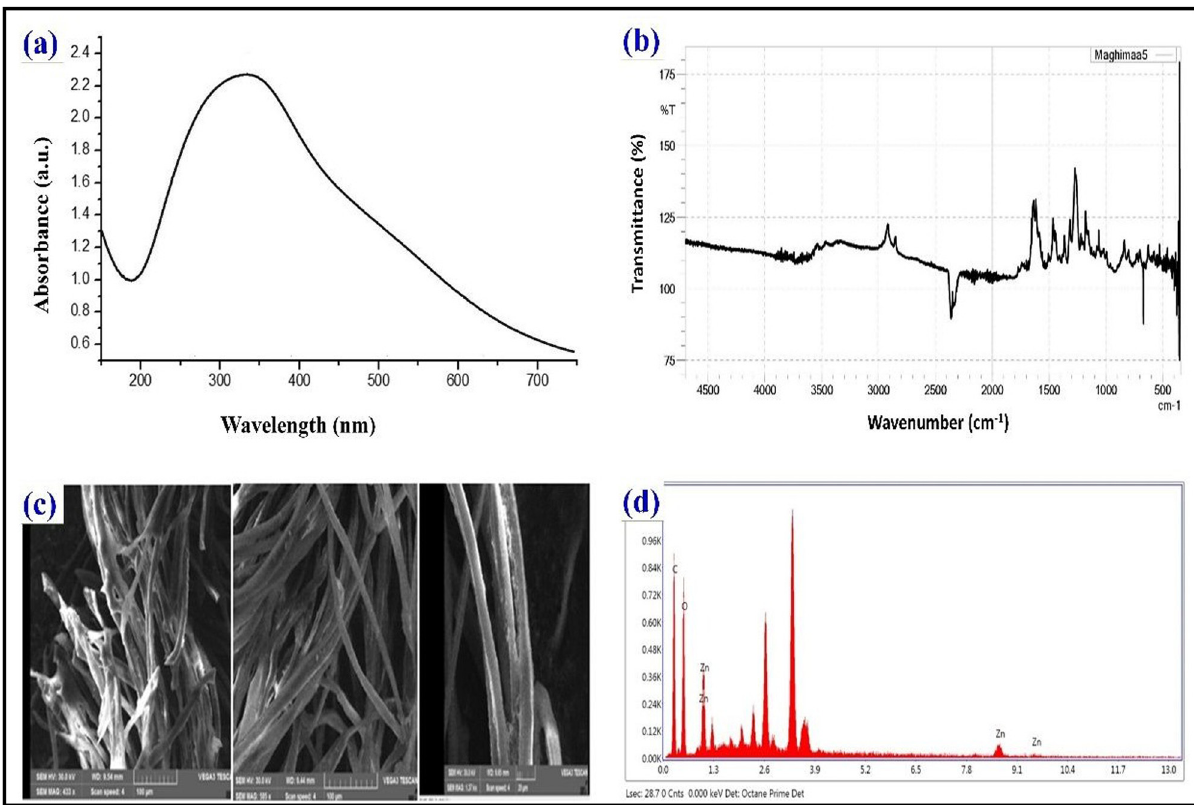
Figure 4: ( a ) UV spectrum analysis of synthesized AS - ZnONPs 350 – 460 nm. ( b ) Spectrum of FT - IR analysis of synthesized AS - ZnONPs. ( c ) SEM with EDX analysis of AS - ZnONP - coated cotton fabric. ( d ) EDX with table energy dispersive X - ray the zinc shows a weight of 8.10% and shows a peak in the range of 7.8 –